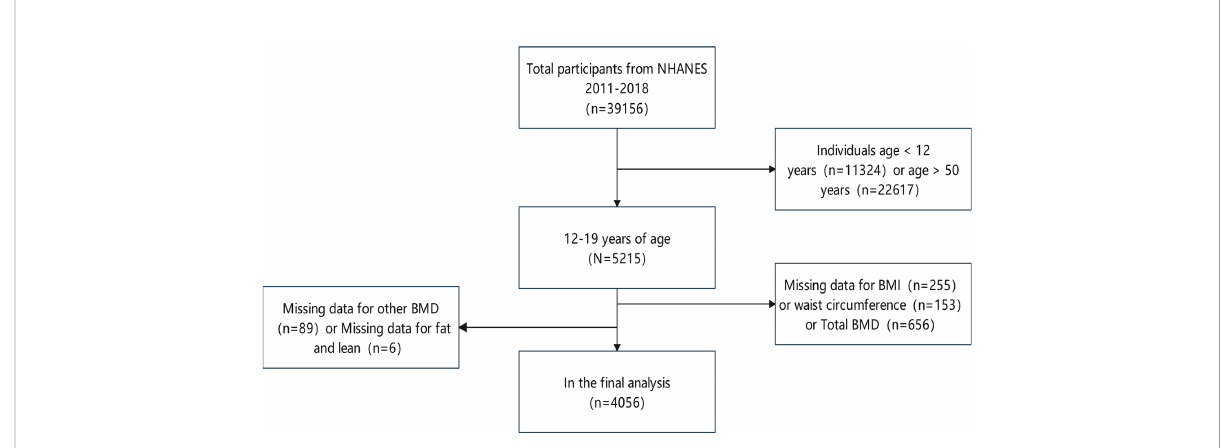
FIGURE 1 Flowchart of participant